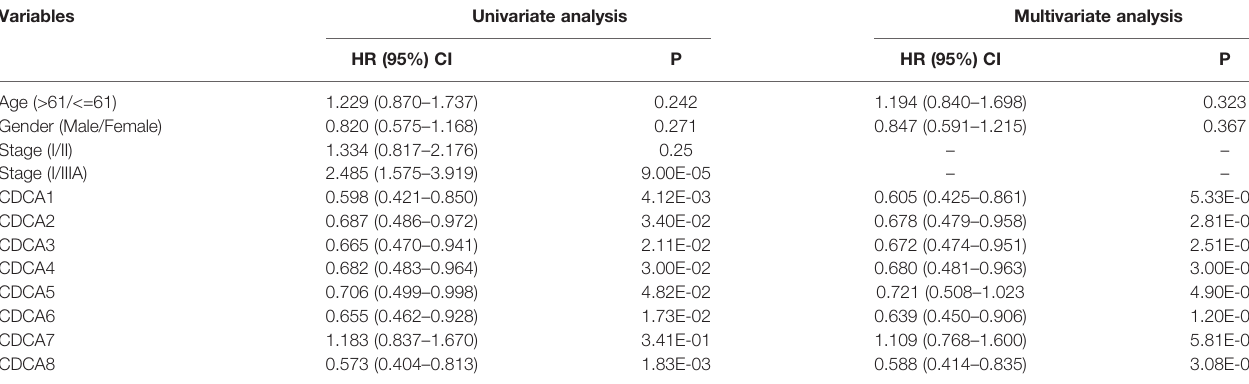
Variables Univariate analysis Multivariate